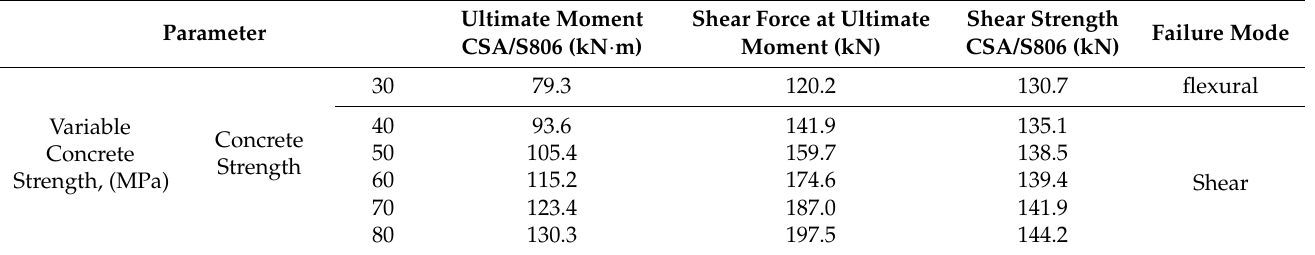
Table 3. The failure mode, bending moment, and shear capacity at ultimate as per CSA/S806 [16].